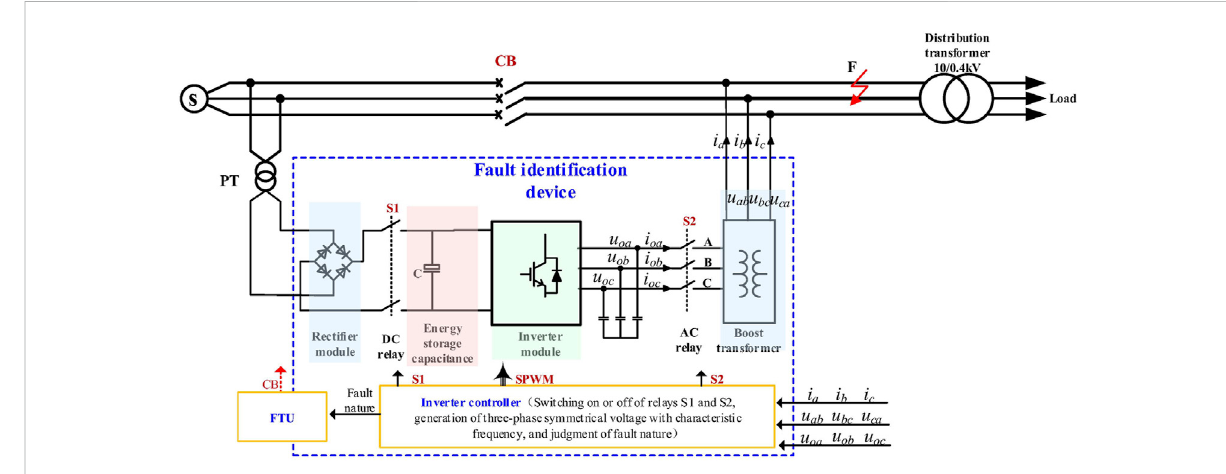
FIGURE1 Overall structure of the fault identi fi cation scheme using power electronics technology.